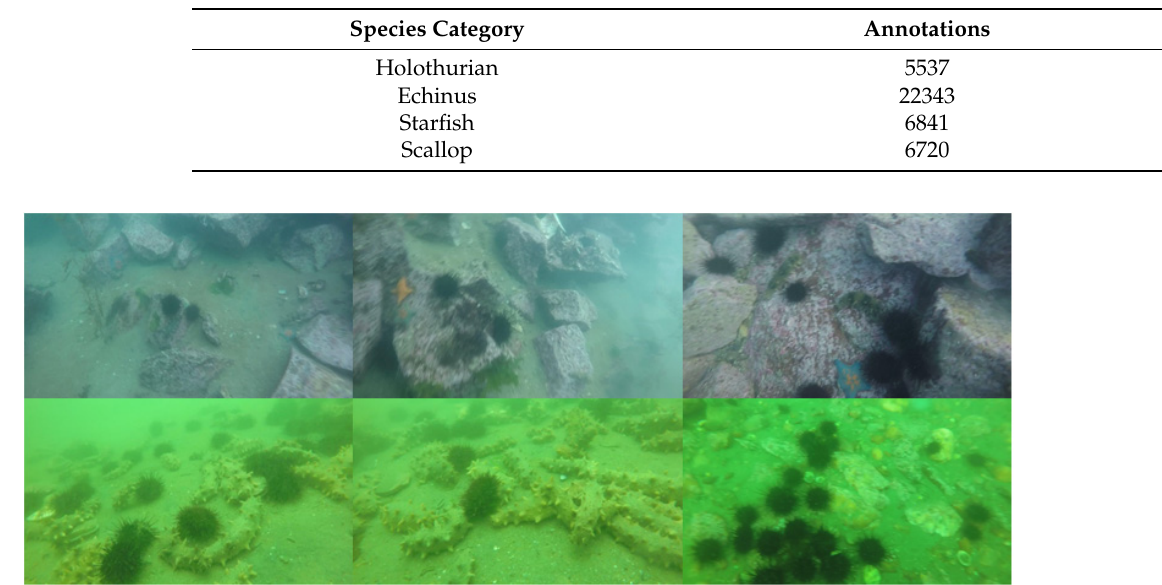
Table 2. Category annotation number of the URPC 2020 dataset.